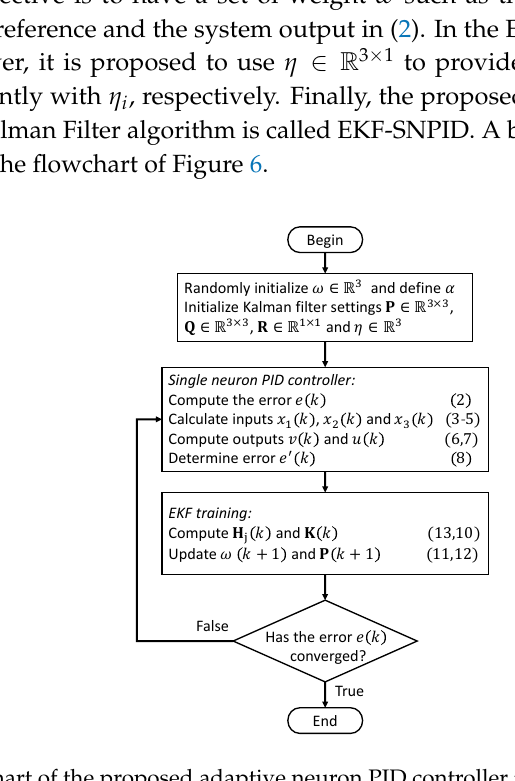
Figure 6. Flowchart of the proposed adaptive neuron PID controller trained with EKF